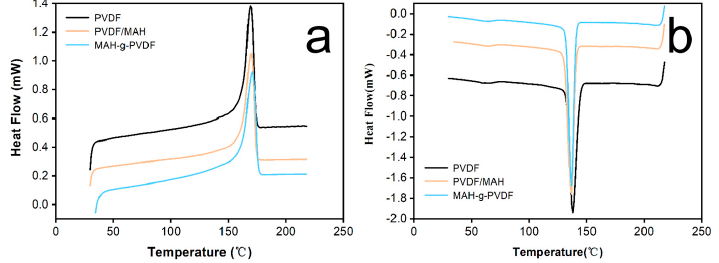
Figure 6. DSC curves of pure PVDF, PVDF/MAH and PVDF-g-MAH (G = 0.63%): ( a ), temperature rise curve; ( b ), cooling curve. Table 1. DSC parameters for PVDF, PVDF/MAH and PVDF-g-MAH composites.